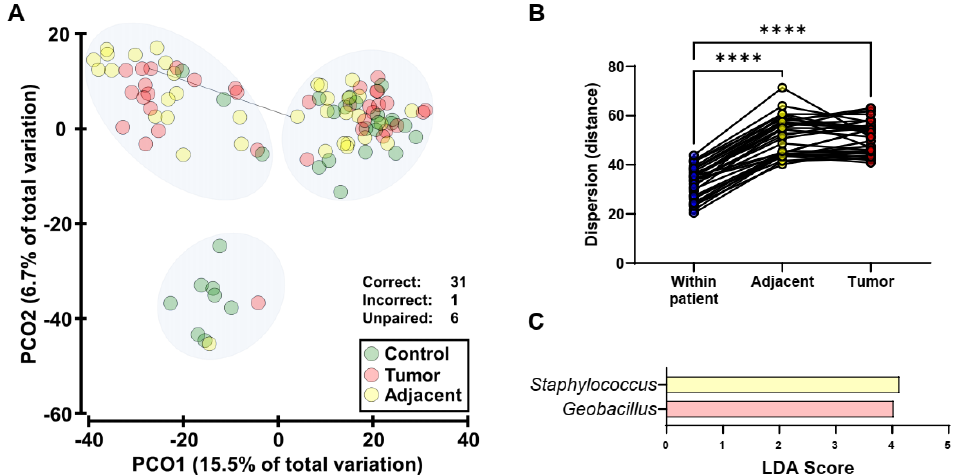
Figure 2. Endometrial microbiota in tumor samples and healthy adjacent tissue. ( A ): Principal coor- dinate (PCO) analysis of bacterial beta diversity across sample types (control, green; healthy adjacent tissue, yellow; tumor tissue, red). The ordinations were generated from Bray-Curtis resemblance ma- trices on square-root transformed bacterial relative abundances. All paired tumor-adjacent samples except one (indicated by connecting line) classified as the same community type. ( B ): Comparisons of dispersions in microbiota composition within patients (tumor-adjacent) against inter-patient (adjacent and tumor). Distances were calculated using the distance-based test for homogeneity of multivariate dispersions (PERMDISP). Significance was tested by ANOVA using Tukey’s multiple comparisons test. **** p < 0.0001. ( C ): Genera that were significantly differentially abundant between tumor samples and adjacent normal tissue. Taxa were identified using Linear discriminant analysis Effect Size (LEfSe). Genera that had a Linear discriminant analysis (LDA) score > 4 are displayed. No taxa were identified when correction for community type was applied.